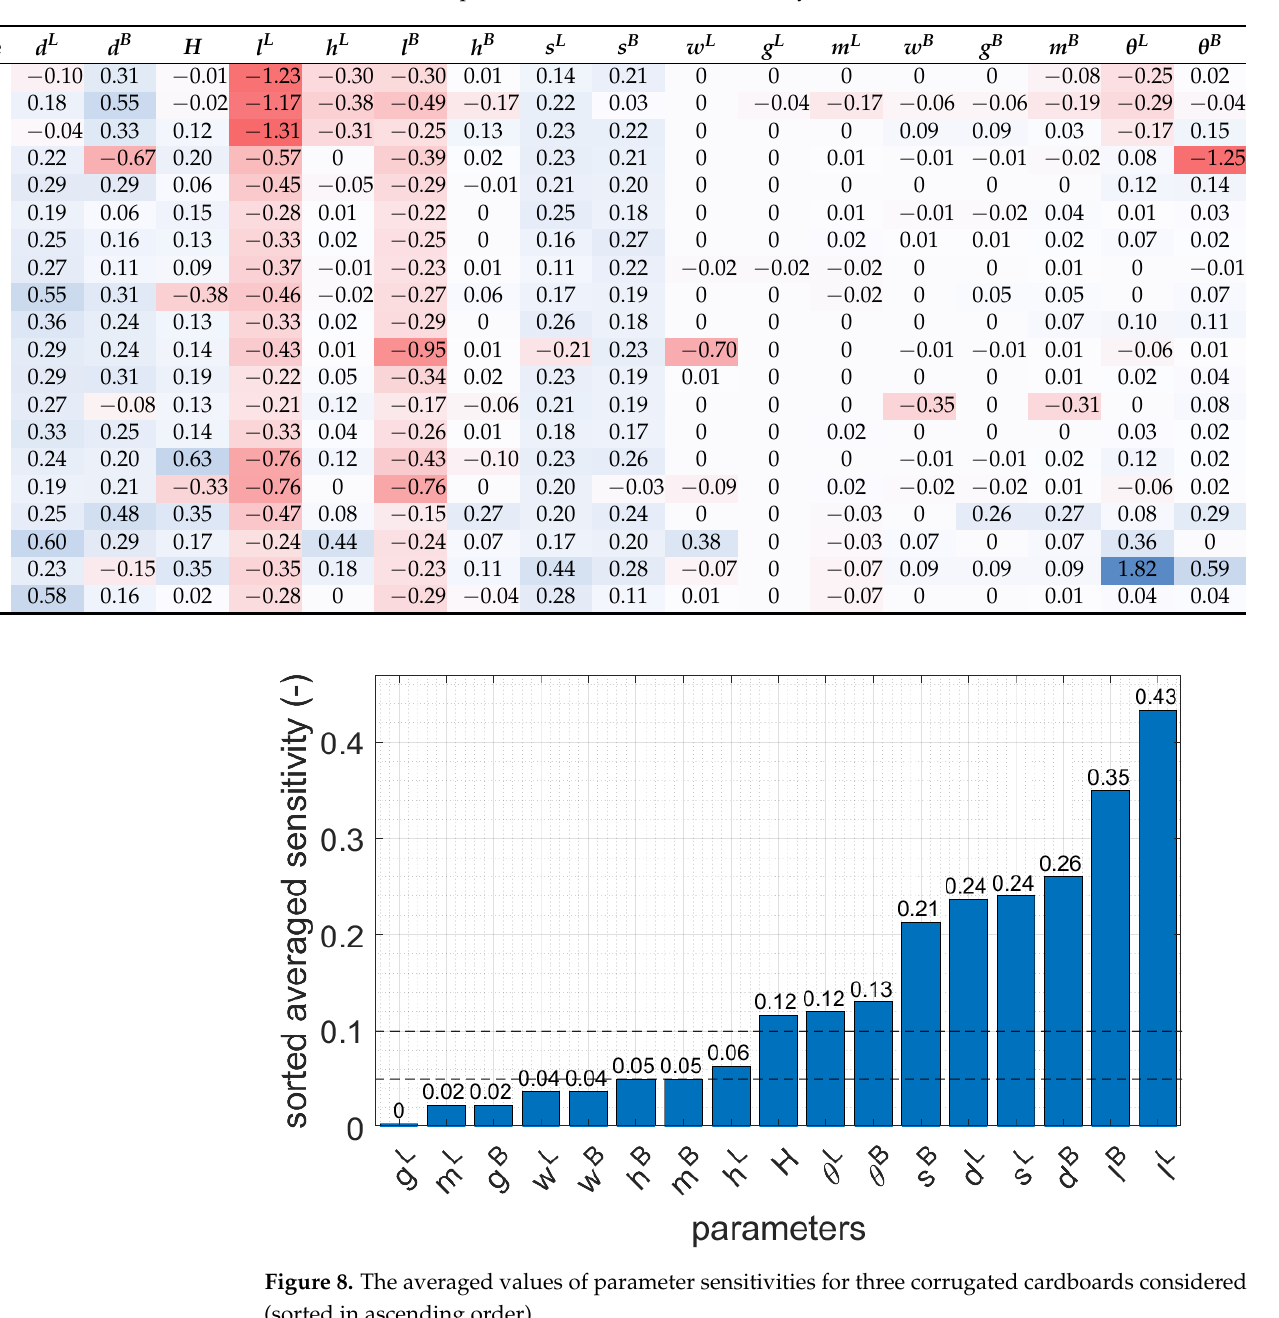
Table 3. Sensitivities computed for B-840 corrugated cardboard with the min/max values marked in blue and red for all parameters considered in the study.